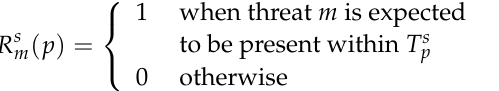
, T s , T s , T s 2 3 1 4